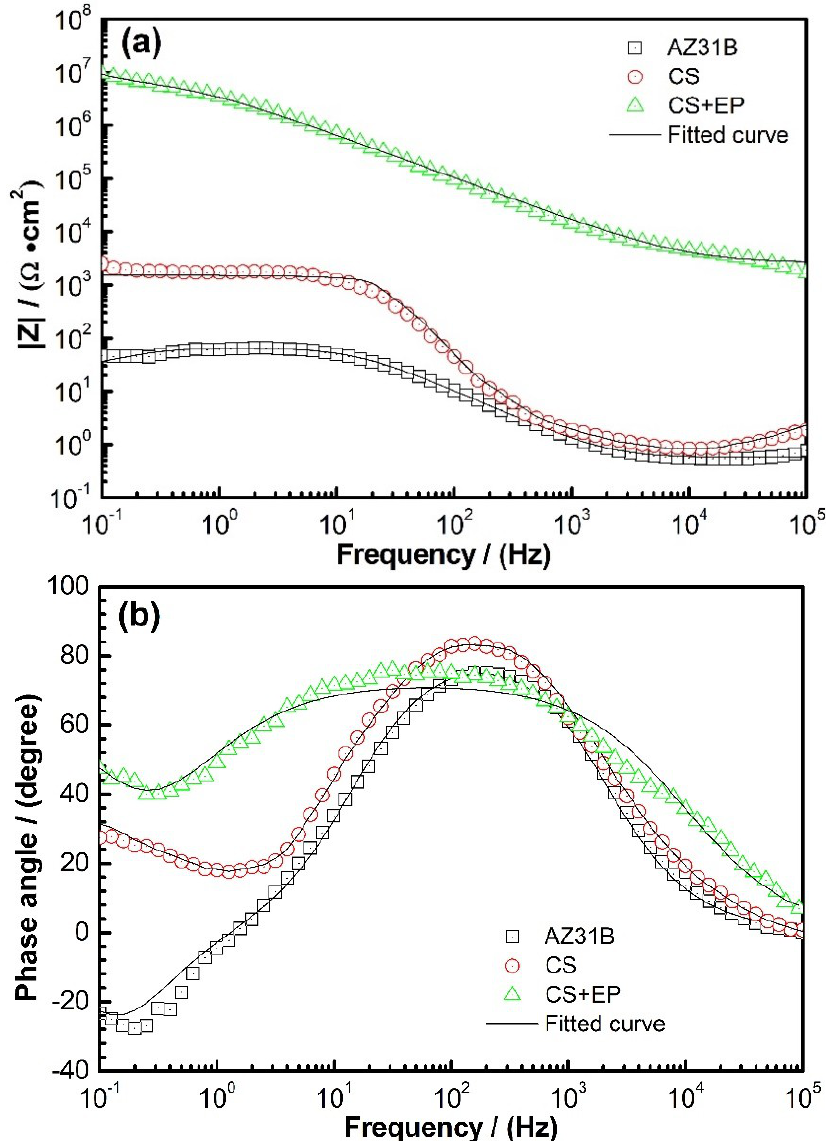
Figure 6. The electrochemical impedance spectroscopy (EIS) data in Bode plot of ( a ) impedance modulus | Z | versus frequency and ( b ) phase angle versus frequency curves for uncoated, CS AA7075 coated and CS + EP coated AZ31B Mg alloy specimens.